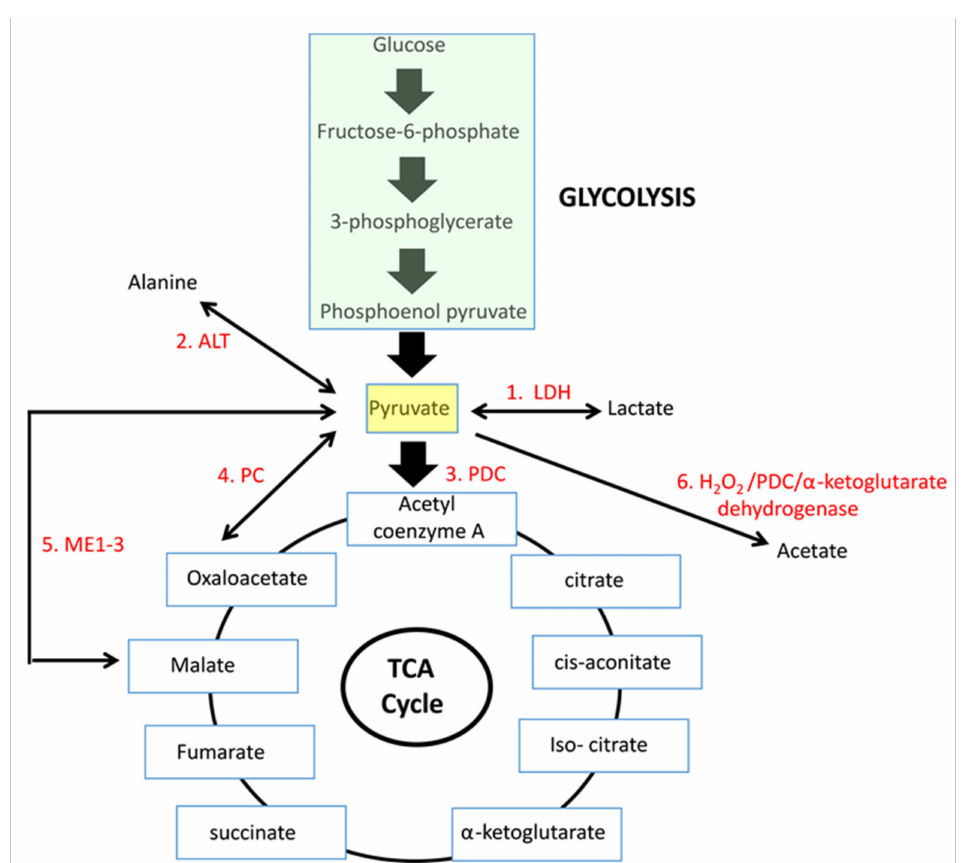
Figure 1. The six metabolic fates of pyruvate. The essentiality of pyruvate to central carbon metabolism is indicated (yellow box) 1. The LDH-mediated reduction to lactate; 2. The alanine amino transferase (ALT)-mediated transamination to alanine; 3. The PDC-mediated oxidation to acetyl- CoA; 4. The PC-mediated anaplerotic conversion to oxaloacetate; 5. The malic enzyme (ME)-mediated conversion to malate, and 6. The non-enzymatic generation of acetate via H 2 O 2 or the enzymatic generation of acetate via PDH or α -ketoglutarate